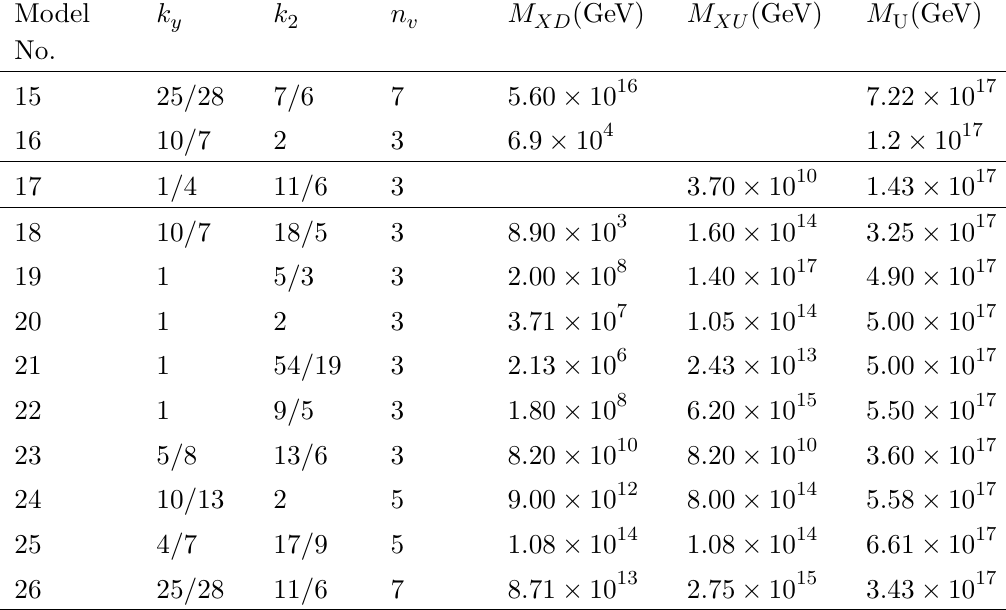
Table 6 . String-scale gauge coupling relations achieved by adding vector-like particles XD + XD or/and XU + XU from N = 2 subsector. The number of vector-like particles are defined by the intersection number on a and c stacks, n